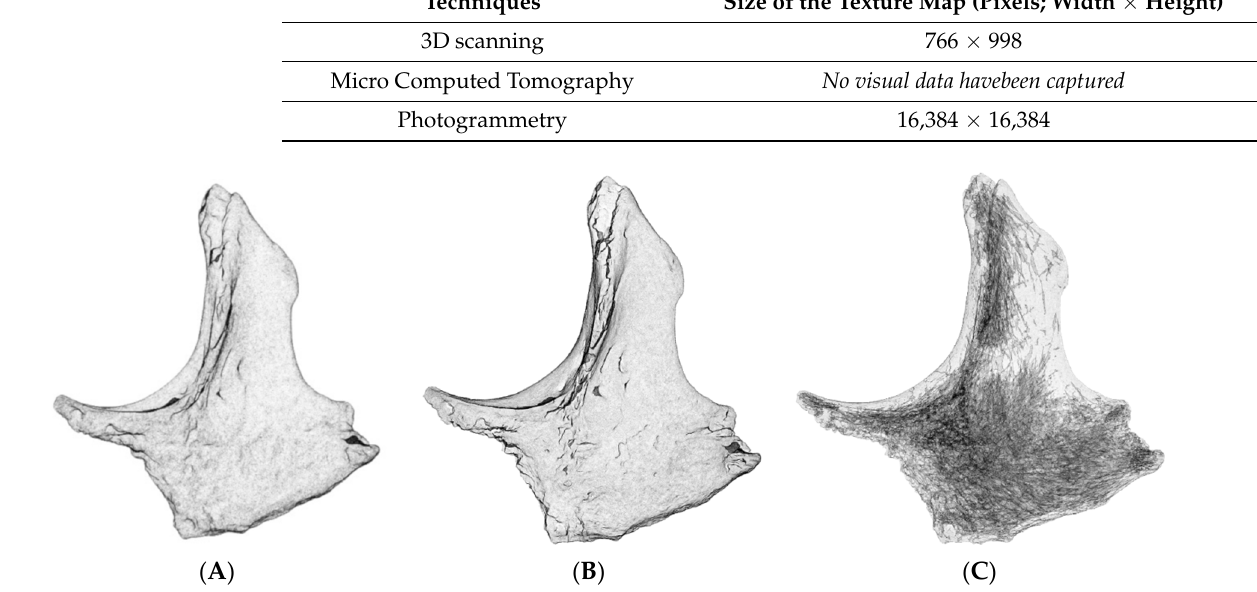
Figure 2. 3D models were created by using different techniques with an X-ray shader applied. ( A ) 3D scanning, ( B ) photogrammetry, ( C ) micro-computed tomography.